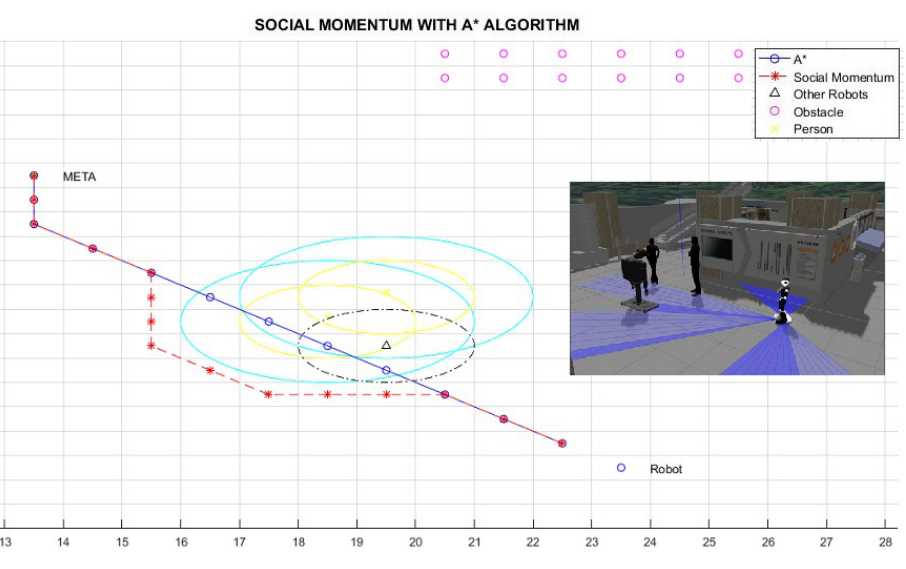
Figure 19. Path 3—Generated proxemic zone in a robot because is near to the proxemic zone of